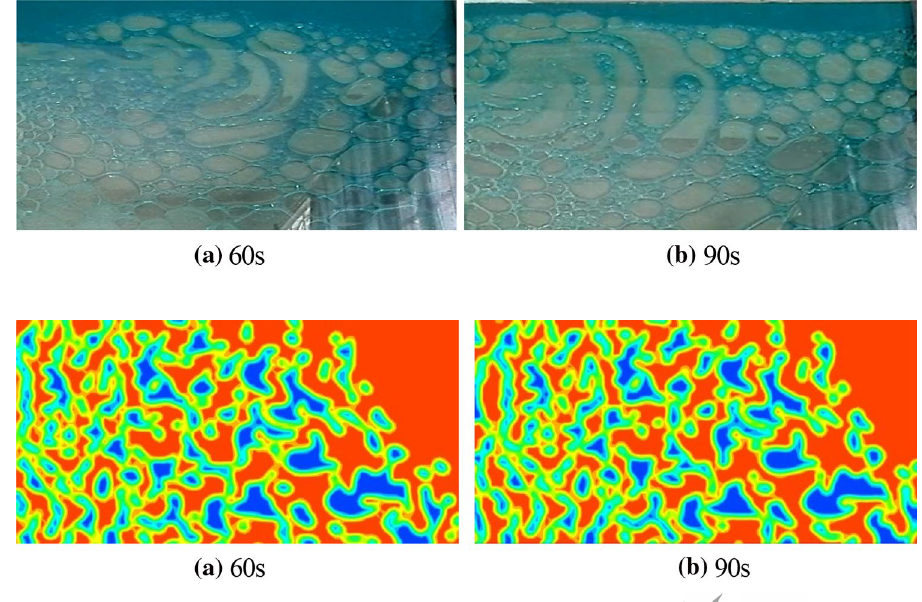
Fig. 4 Results of numerical simulation